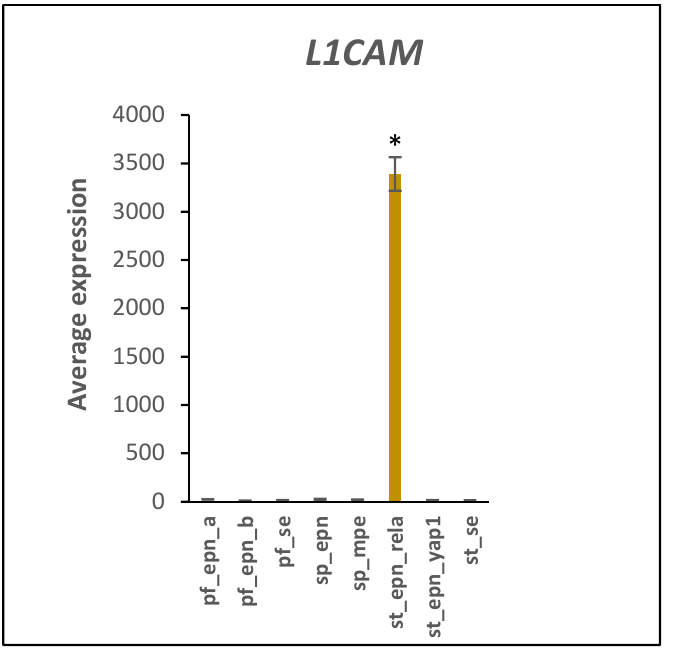
Figure 9. Gene encoding stem cell marker and cell adhesion factor, L1CAM , overexpressed in ST_EPN_RELA (by Anova, F = 173.55, p = 1.35 × 10 − 81 ). * significantly different from all other groups at p < 0.001. Dataset GSE64415.